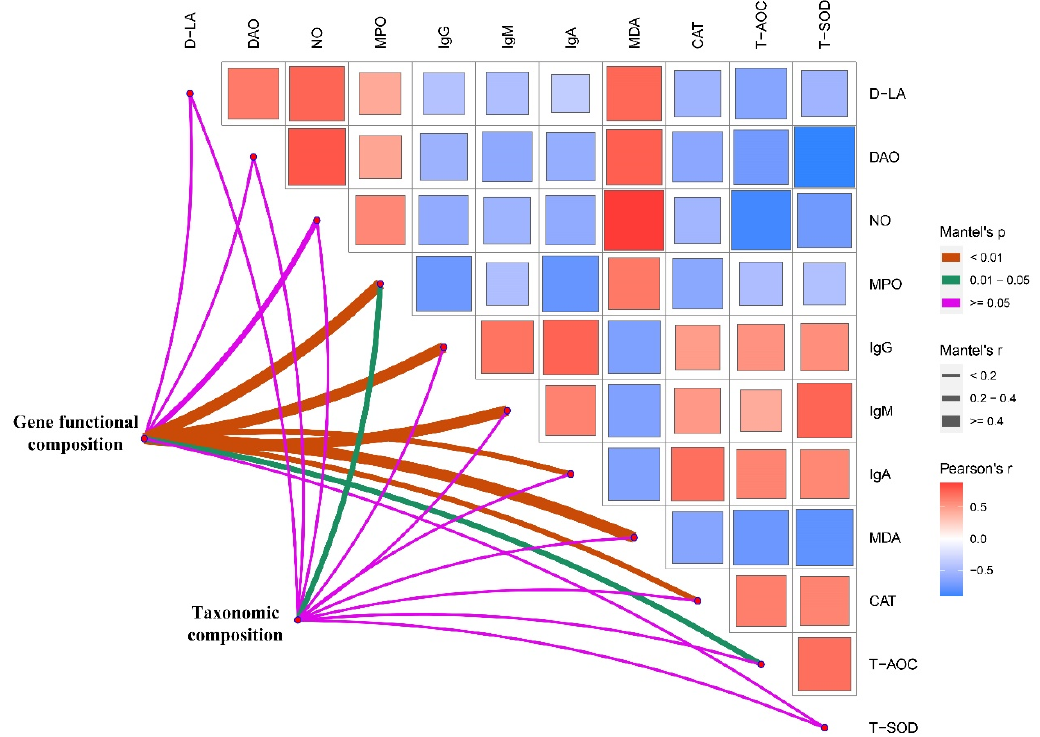
Figure 11. Relationships among phenotypic variables, the microbial community, and metabolic functional composition. Pairwise comparisons of phenotypic variables with a color gradient denot- ing Pearson correlation coefficient. Taxonomic and functional community structures were related to each phenotypic variable by Mantel correlation (based on Bray–Curtis dissimilarity). The edge width represents the Mantel’s r statistic for the corresponding distance correlations, and the edge color denotes the statistical significance.